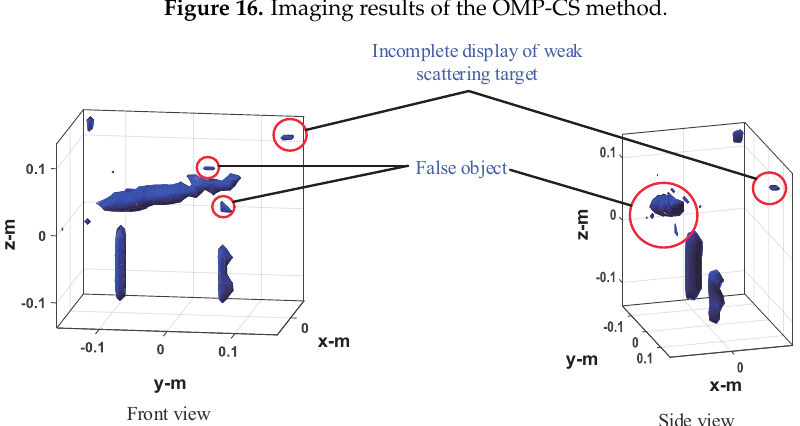
Figure 16. Imaging results of the OMP-CS method.